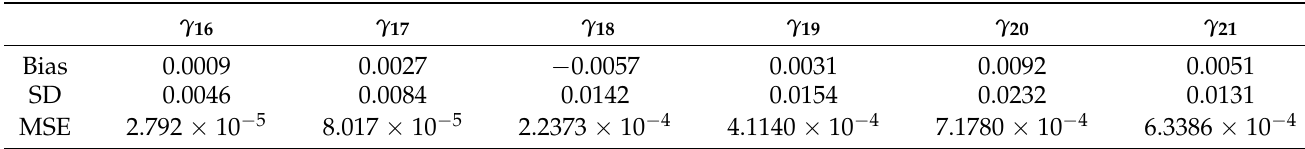
Table 5. Bias, SD and MSE evolutions with respect to the parameter γ variation for GNFPLSIM with the identity link function and n = 500.